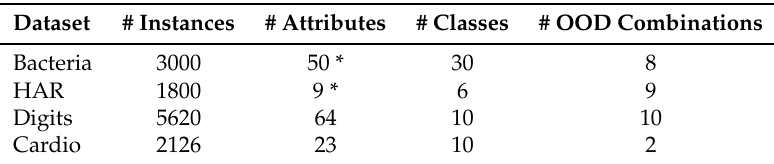
Table 1. Datasets used and their